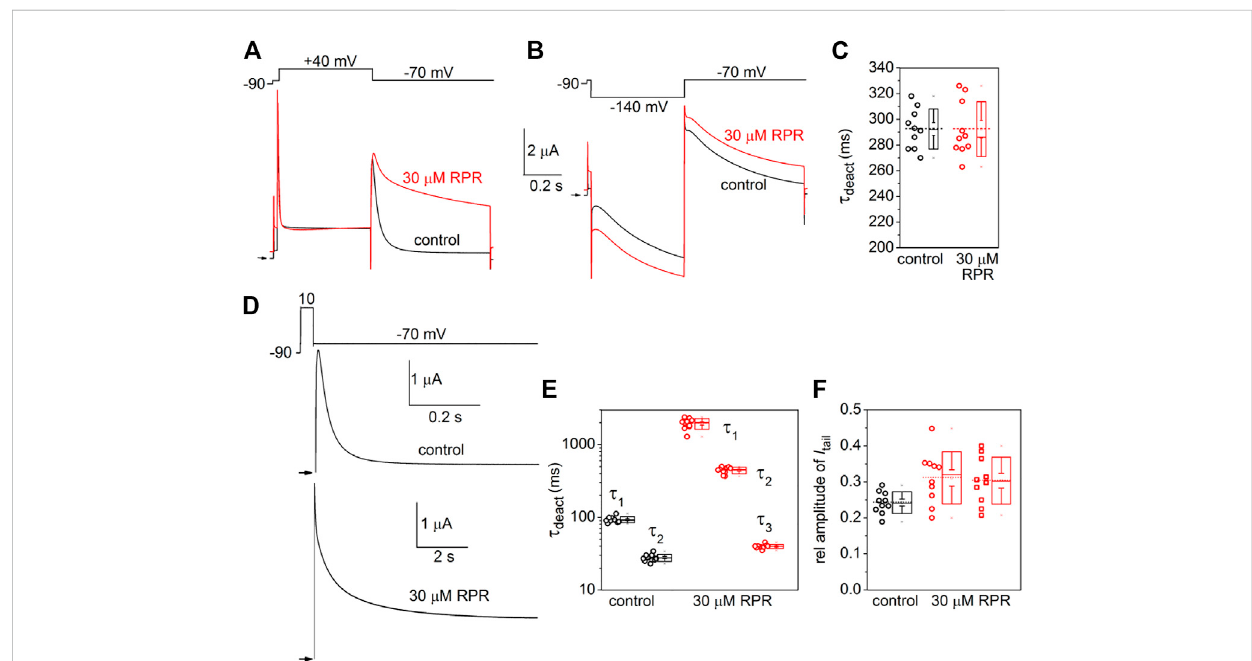
FIGURE 7 Differential effects of RPR on deactivation of D540K hERG1a channels opened by depolarizing or hyperpolarizing pulses. (A) RPR slowed the rate of current measured at a V ret of − 70 mV after channels were activated by a 0.5 s depolarization to 40 mV. (B) RPR did not alter the rate of current deactivation of current measured at a V ret of − 70 mV after channels were activated by a 0.5 s hyperpolarization to − 140 mV. (C) Scatter plot for τ deact measuredat − 70 mVfollowinga0.5 spulseto − 140 mV( n =10).Plottorightofdataindicatesmean(dashedline),S.E.M.(whiskers)andS.D.(box). (D) Voltage pulse protocol and corresponding tail currents measured from an oocyte before (control) and after RPR. Channels were activated by a 0.5 s prepulse to 10 mV. Note difference in time scale for different conditions. (E) Scatter box plots for effect of 30 µM RPR on τ deact measured at − 70 mV